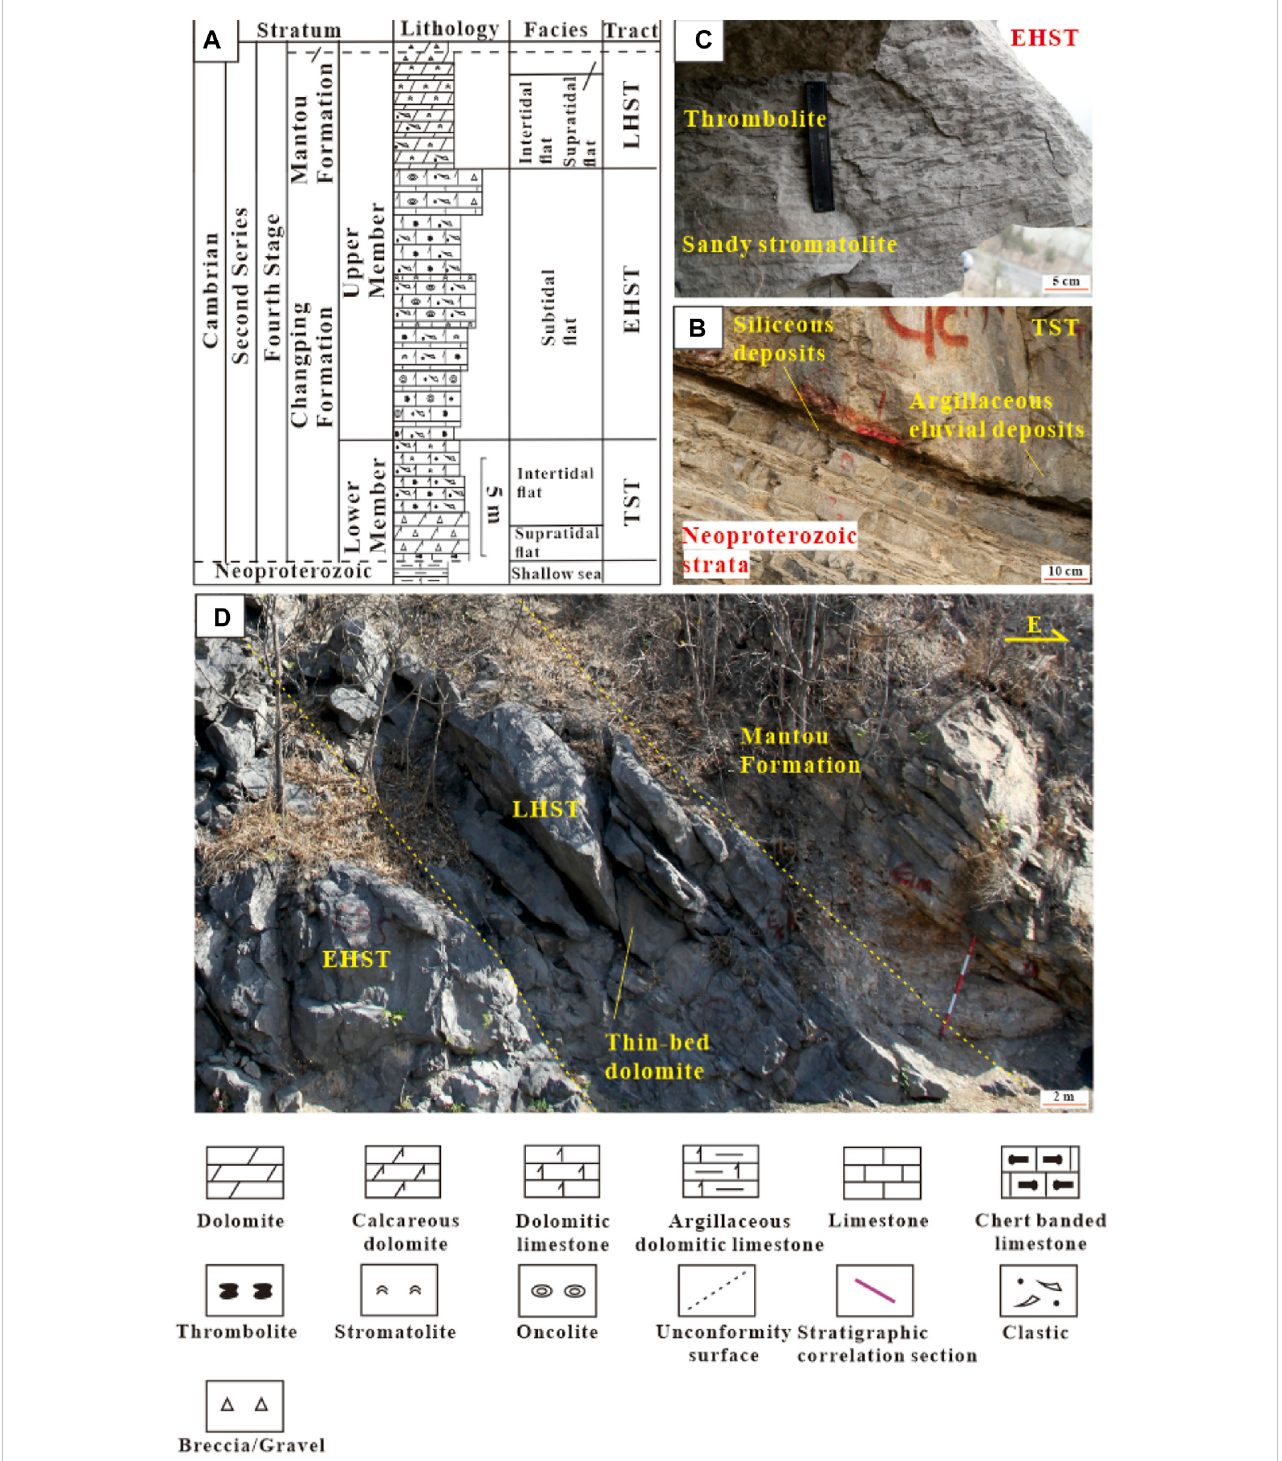
FIGURE 2 Stratigraphic characteristics of the Cambrian Changping Formation in the study area. (A) Comprehensive stratigraphic column of the Changping Formation (after Bai et al., 2019; Bai et al., 2021b). (B) Siliceous and argillaceous eluvial deposits in the TST, Dingjiatan section. (C) Sandy stromatolite and thrombolite in the EHST, Dingjiatan section. (D) Thin-bed dolomite in the LHST, Dingjiatan